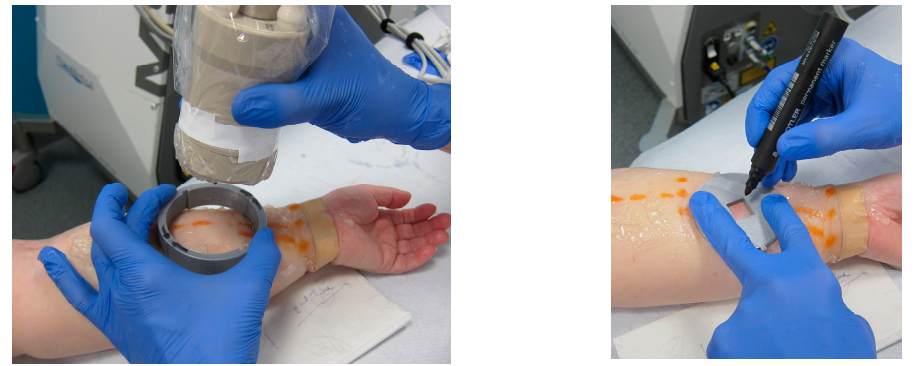
Figure 6. The incision site for surgery was marked with the help of a custom-made pointer. J. Clin. Med. 2020 , 9 , x FOR PEER REVIEW